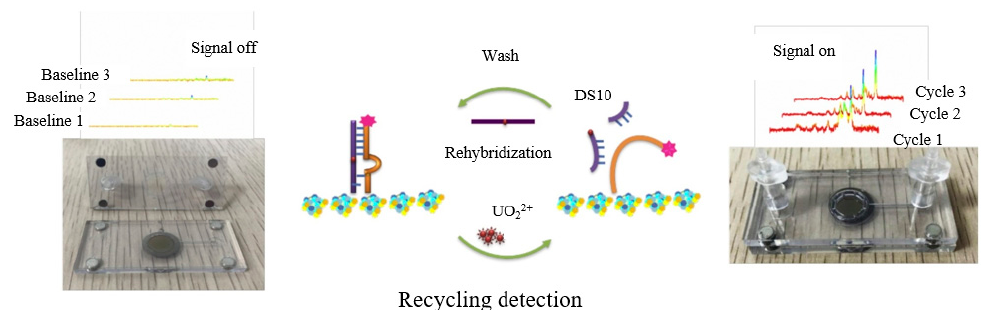
Figure 3. Ultra-sensitive recyclable SERS microfluidic biosensor for the detection of UO 22+ [62].